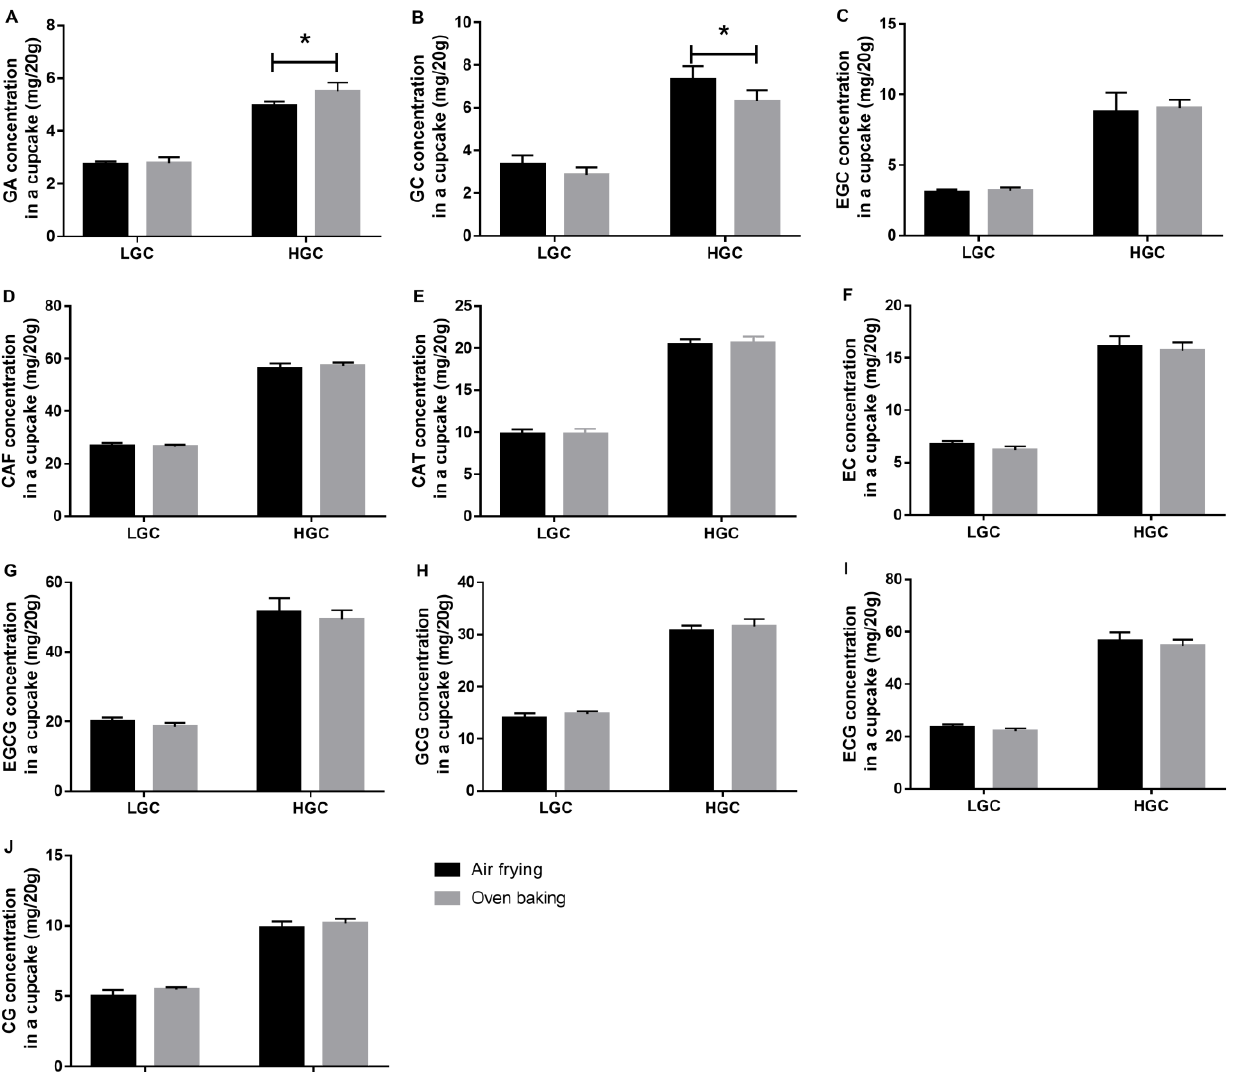
Figure 5. Comparison of GTCs and caffeine in air-fried and oven-baked cupcakes. ( A – J ) Comparison of GA, GC, EGC, CAF, CAT, EC, EG, GCG, ECG, and CG, respectively. * p < 0.05. LGC, the low level of green-tea-fortified cupcake; HGC, the high level of green-tea-fortified cupcake; GA, gallic acid; GC, (−)-gallocatechin; EGC, (−)-epigallocatechin; CAF, caffeine; CAT, (+)-catechin; EC, (−)-epicatechin; EGCG, (−)-epigallocatechin-3-gallate; GCG, (−)-gallocatechin-3-gallate; ECG, (−)-epicatechin-3-gallate; CG, (−)-catechin-3-gallate.